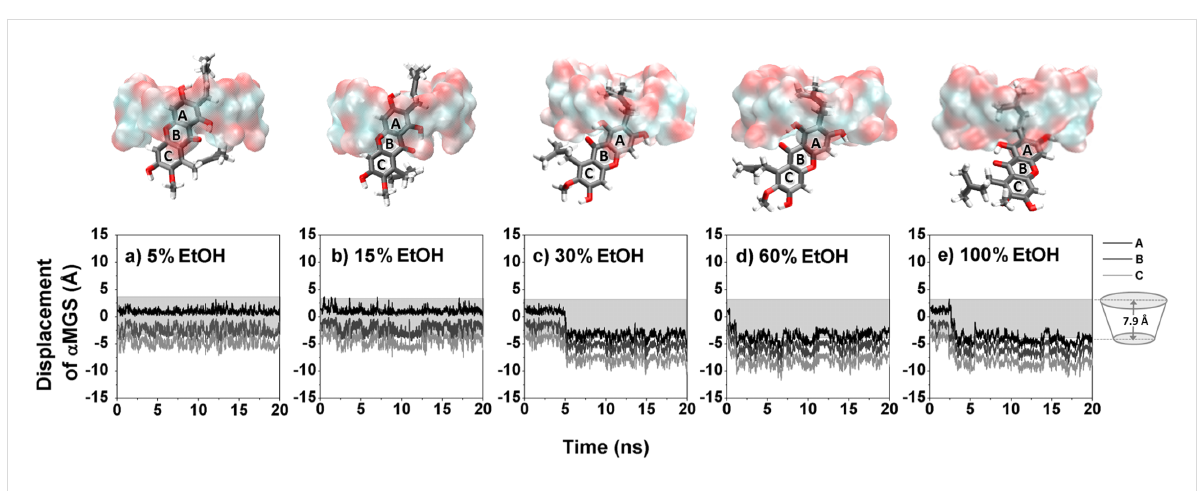
Figure 5: Displacement of the A–C rings of α -MGS with respect to the β -CD center of gravity for five systems having different ethanol percentages a) 5%, b) 15%, c) 30%, d) 60% and e) 100%. The last snapshot of each system is displayed above each graph.